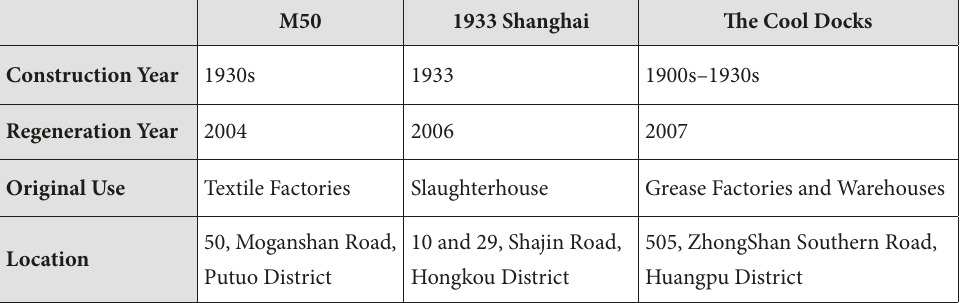
Table 1 Background information of the selected three study cases (Source: Xiangyi